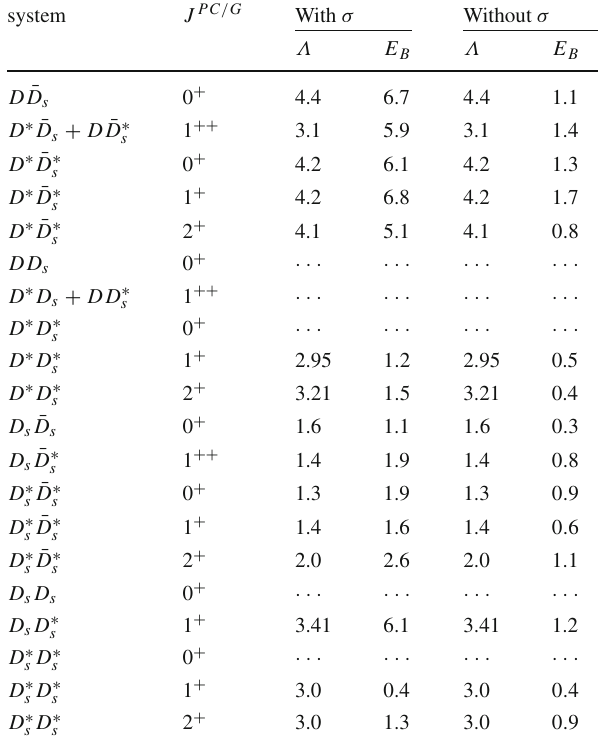
Table 6 The binding energies of some bound states with some selected values of cutoff Λ . The results with σ exchange are listed 3–4th columns. The result without σ exchange are listed 5–6th columns. The cutoff Λ and binding energy E B are in the units of GeV and MeV system J PC / G With